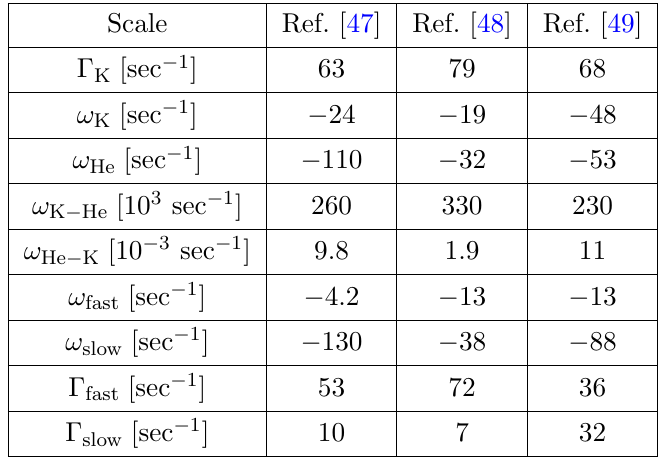
Table 2 . The important scales which appear in eq. (A.3), calculated using the values of table 1. The (cid:0) (cid:0) fast + i! fast ; (cid:0) (cid:0) slow + i! slow are the eigenvalues of the matrix in eq. (A.3). The \fast" (\slow") subscript corresponds to the mode that far from the compensation point was the alkali (noble) spins’